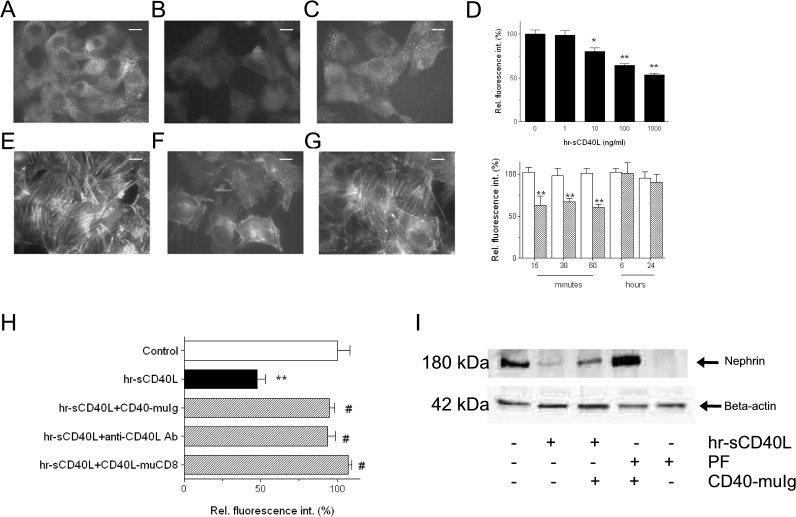
Effect of sCD40L on nephrin expression and cytoskeleton organization in cultured GECs.(A-C) Micrographs representative of immunofluorescence staining for nephrin in non-permeabilized GECs: (A) GECs incubated with vehicle alone for 30 min; (B) GECs incubated with hr-sCD40L (100 ng/ml + 1 μg/ml enhancer) for 30 min; (C) Effect of pretreatment with an inhibitor of CD40-CD40L interaction, CD40-muIg fusion protein (20 ng/ml), on loss of nephrin induced by hr-sCD40L. Original magnification: ×400 (F-H). Bars = 10 μm. Images are representative of at least 5 separate experiments with similar results. (D) Semiquantitative analysis of nephrin expression as detected by immunofluorescence staining in GECs incubated with various concentrations of hr-sCD40L for 30 min (upper graph), and of the time-course effect of incubation of GECs with hr-sCD40L (100 ng/ml + 1 μg/ml enhancer; dashed bars) or vehicle alone (open bars) on nephrin expression, as detected by immunofluorescence staining (lower graph). Values are derived from 5 or more experiments for each experimental condition and expressed as percent variations from baseline value. (E-G) Micrographs representative of fluorescein isothiocyanate phalloidin staining of actin microfilaments in permeabilized GECs. (E) GECs incubated with vehicle alone for 30 min; (F) GECs incubated with hr-sCD40L (100 ng/ml + 1 μg/ml enhancer) for 30 min; (G) Effect of pretreatment with an inhibitor of CD40-CD40L interaction, CD40-muIg (20 ng/ml), on reorganization of cytoskeleton induced by hr-sCD40L. Original magnification: ×400 (D-I). Bars = 10 μm. Images are representative of at least 5 separate experiments with similar results. (H) Semiquantitative analysis of nephrin expression as detected by immunofluorescence staining in GECs incubated with hr-sCD40L (100 ng/ml + 1 μg/ml enhancer) for 30 min in the absence (black bar) or presence of different inhibitors of CD40-CD40L interaction (dashed bars). Using CD40-muIg fusion protein (20 ng/ml) and the neutralizing antibody against CD40L (5 μg/ml), hr-sCD40L was pre-treated for 10 minutes prior to GEC stimulation, whereas the CD40L-muCD8 fusion protein (50 ng/ml) was added to cultured GECs 30 minutes before adding hr-sCD40L (see Methods for details). Values are derived from 5 or more experiments for each experimental condition and expressed as percent variations from baseline value. (I) Immunoblot of a representative experiment on the effect of hr-sCD40L and PF on nephrin expression as detected by Western blot analysis. GEC lysates were immunoblotted with antibodies anti-nephrin or Beta-actin after incubation with hr-sCD40L (100 ng/ml + 1 μg/ml enhancer) or PF (500 ng/ml), in the presence or absence of CD40-muIg fusion protein (20 ng/ml) to inhibit CD40-CD40L interaction. Blots are representative of three independent experiments with similar results.